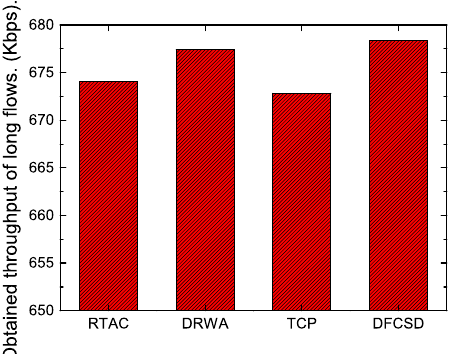
Figure 9. The obtained throughput of the long flows when a short flow competes with a long flow whose sizes are 128 KB and 10 MB,